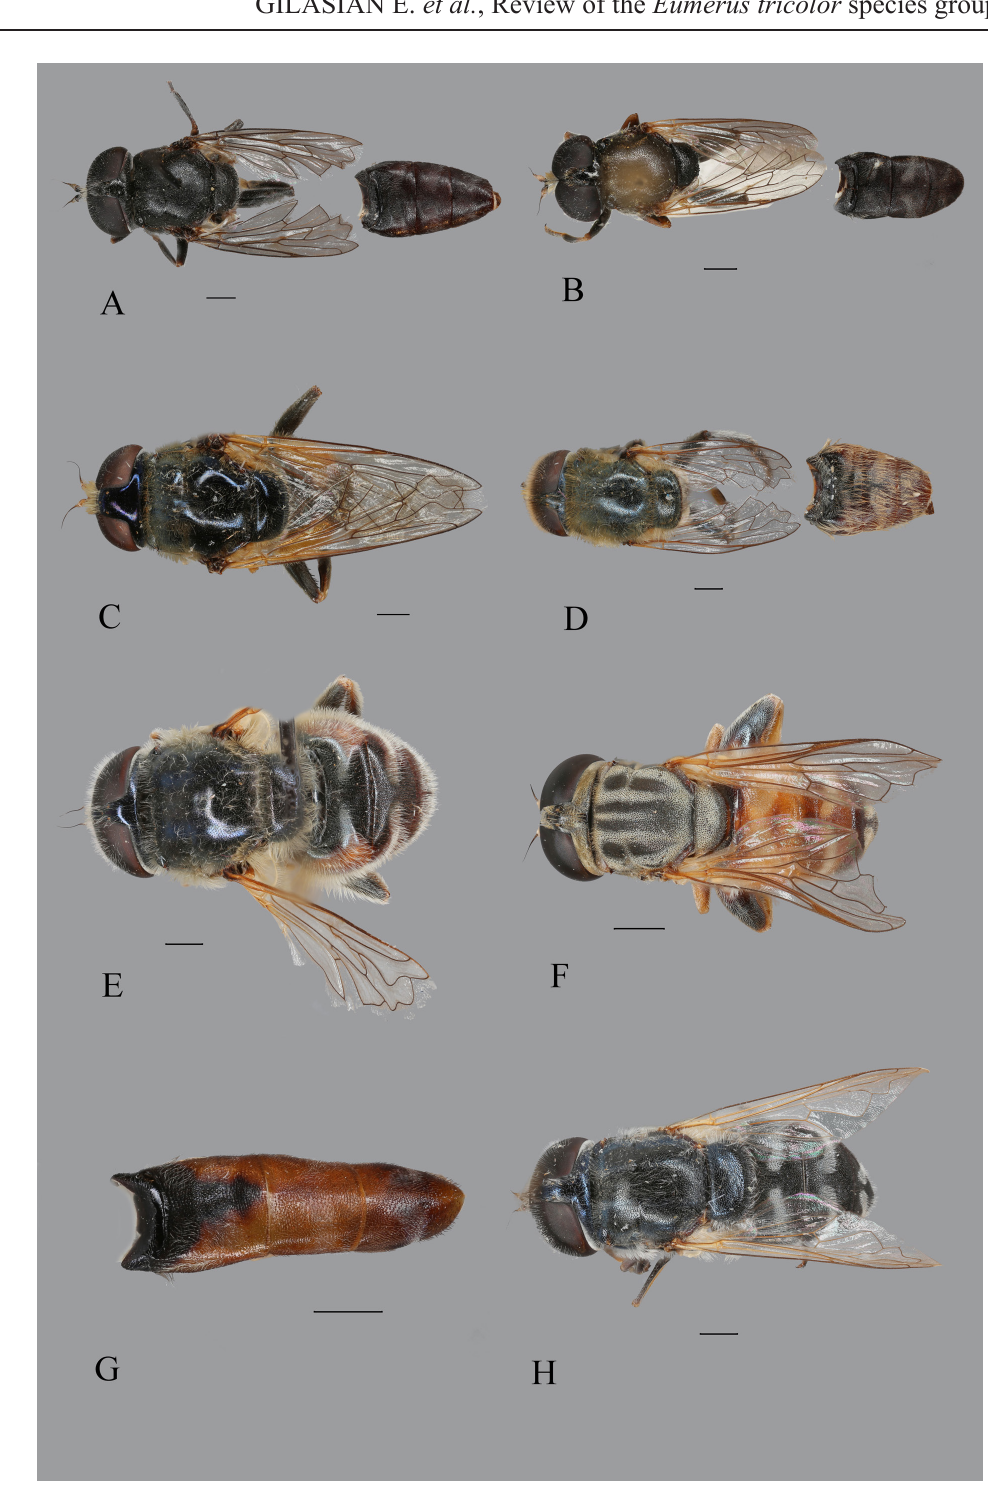
Fig. 3. Adult habitus, ♂, dorsal view. A . Eumerus atricolorus Gilasian & van Steenis sp. nov., holotype (HMIM). B . E. brevipilosus Gilasian & van Steenis sp. nov., holotype (HMIM). C . E. falsus Becker, 1922, Chekab Valley, Iran (HMIM). D . E. chekabicus Gilasian & van Steenis sp. nov., holotype (HMIM). E . E. coeruleus (Becker, 1913), Chekab Valley, Iran (JSA). F . E. jacobsoni Becker, 1913, Chekab Valley, Iran (JSA). G . E. kazanovzkyae Paramonov, 1927, abdomen, Paveh, Iran (HMIM). H . E. longitarsis Peck, 1979, Chekab Valley, Iran (JSA). Scale bars = 1.0